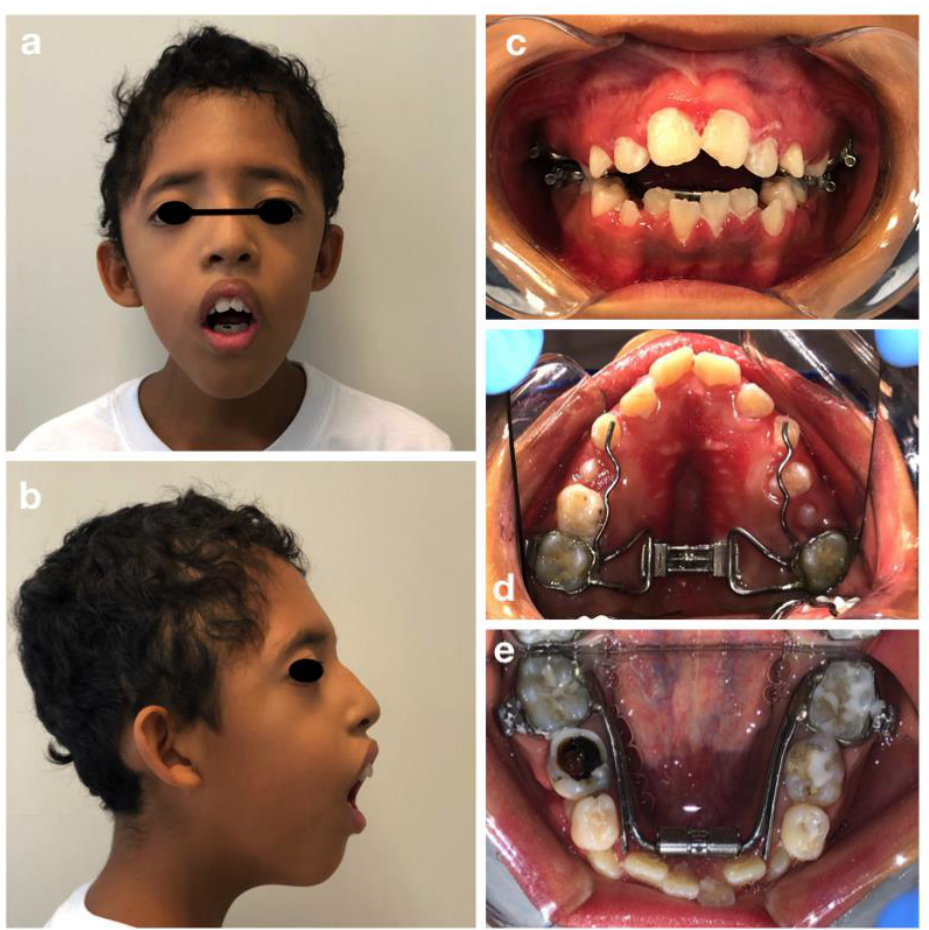
Figure 2. Crouzon syndrome: extra-oral ( a , b ) and intra-oral pictures ( c – e ). Upper and lower arch expanders are present ( d , e ). An arrested cavitated caries lesion in a second primary molar (8.5) is evident ( e ).